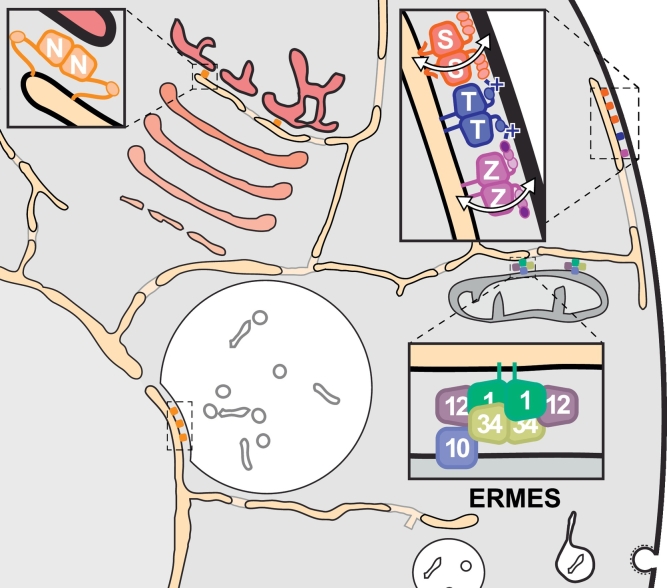
Intracellular targeting of proteins with SMP domains. SMP domain proteins are shown as small coloured rectangles at four intracellular locations, all of which are contact sites that involve the ER. Insets show expanded views at three contacts of SMP and associated domains, all of which are explained in Fig. 1B, except for the polybasic region of Tmem24 (“+”), which is otherwise like E-Syts, though with one C2 domain [33]. The associated domains can bind non-ER membrane determinants including phosphoinositides and other anionic lipids. At ER-mitochondrial contacts three SMP proteins in ERMES (Mmm1 “1”, Mdm12 “12”, Mdm34 “34”) form a bridging complex along with the porin Mdm10 (“10”). It is not known which component binds directly to Gem1, which has been omitted for clarity. The complex is likely to transfer at least one lipid, possibly more. At ER-plasma membrane contacts three different types of SMP protein are found: E-Syts (“S”), Tmem24 (“T”) and PDZK8 (“Z”). Each SMP protein (and each E-Syt) may transfer a specific lipid. ER contacts with both the yeast vacuole (nucleus-vacuole junction) and the trans Golgi network can be populated by yet another SMP protein, Nvj2 (“N”), which may transfer ceramide [102]. Only ER-trans Golgi network contacts are shown because they are more likely to represent the site of conserved function; organisation of Nvj2 at the nucleus-vacuole junction (which is less obviously conserved) would be highly similar. Other targeting by SMP proteins includes Arabidopsis E-Syt2.1 (SYT5) at intracellular puncta [86], but it is not yet known whether these are contact sites or which organelles are involved. In most of these examples the lipids transferred are not yet defined clearly. In addition, if the shuttle model applies, two lipids may be exchanged in a counter-current [43].